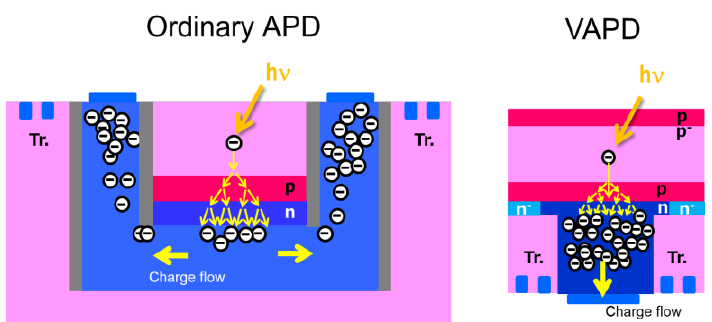
Figure 1. Schematics of cross sectional structures of an ordinary avalanche photodiodes (APD) pixel ( left ) and vertical avalanche photodiodes (VAPD) ( right ).